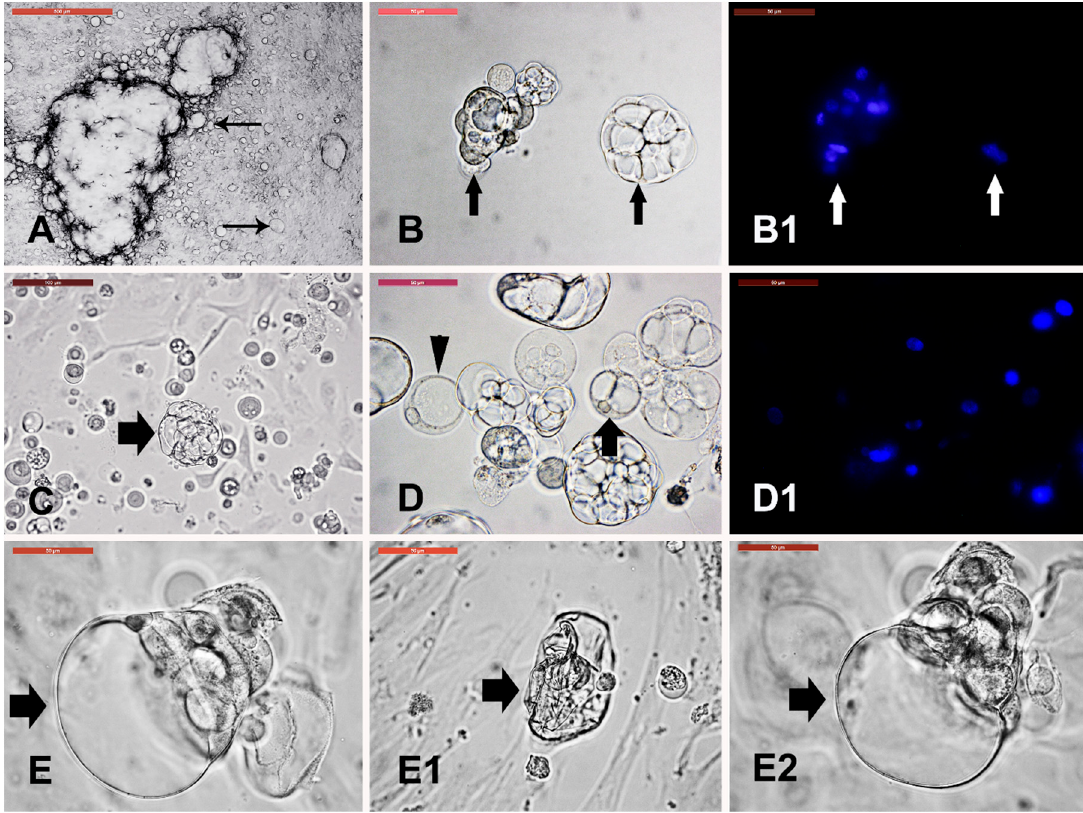
Figure 6. Cystic cells subculture, cryopreservation, and characterization. ( A ) Cystic cell (arrows) monolayer was dissociated and cells were subcultured. ( B ) Groups of cells with cysts and individual cells with different fluid-filled compartments (arrows) at passage 1 (P1). ( B1 ) Hoechst staining of nuclei of groups in ( B ). ( C ) Consistent formation of cystic cells (arrow) after cryopreservation of passage 3 (P3) with different numbers of fluid-filled compartments. ( D ) Single (arrowhead); double (arrow); and more than two compartments as distributed in the field. ( D1 ) Hoechst staining of nuclei of cells shown in ( D ). ( E ) Exposure of the cystic cells (arrow) to osmotic stress (500 mOsm/L for 3 min) showed cyst collapse (( E1) , arrow), which was reformed after recovery (( E2 ), arrow) at 300 mOsm/L for 15 min. Scale bar = 50 µm except for ( A , C ) are 500 µm.